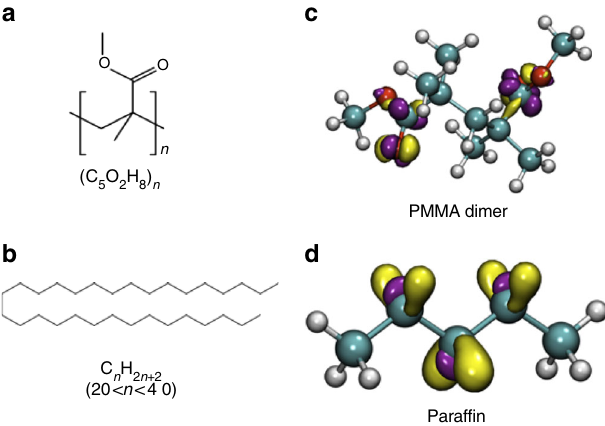
Fig. 5 Chemical structures, formulae, and isosurfaces of a PMMA dimer and a paraf fi n molecule. Chemical structures and formulae of a PMMA and b paraf fi n, and the isosurfaces of the Fukui function for c a PMMA dimer and d a paraf fi n molecule. Carbon atoms in green, hydrogen atoms in gray, oxygen atoms in red. Yellow isosurfaces represent those regions of the molecule that undergo electrophilic attack upon chemical reaction, and purple represents regions that undergo nucleophilic attack